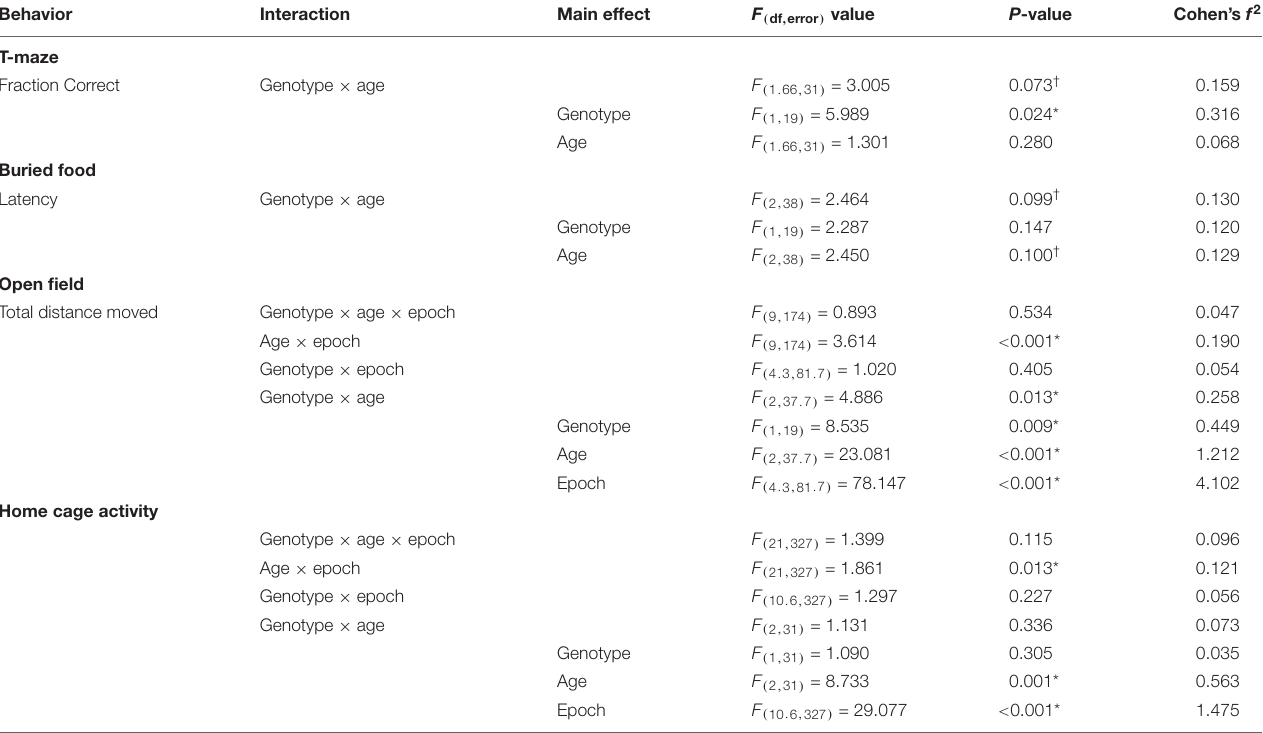
TABLE 2 | Repeated measures ANOVA results behavior testing in